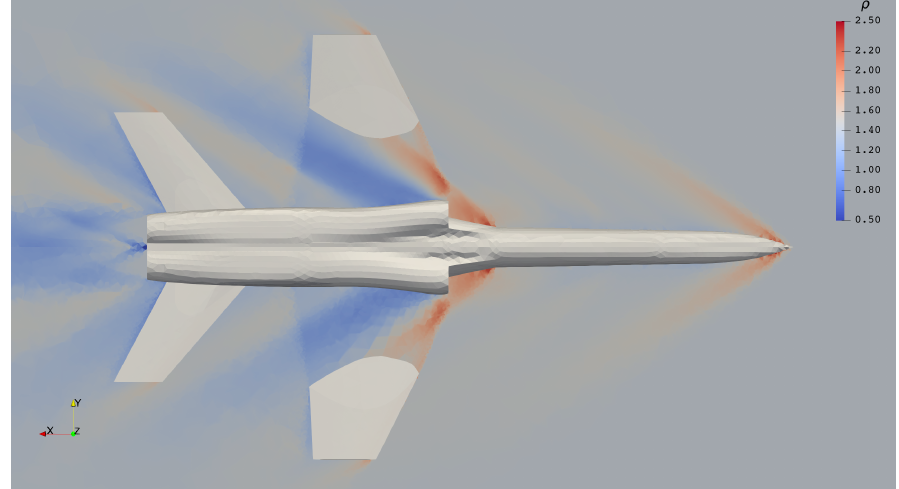
Figure 27. Comparison between the third-order solution (upper half) and the first-order solution (lower half) of Problem 6 on the z = 0 surface (bottom